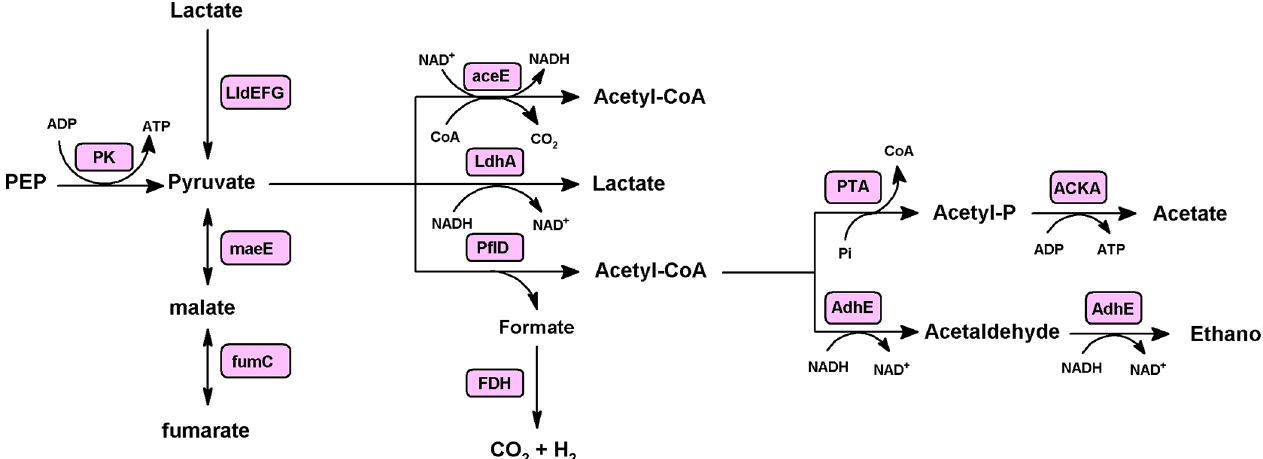
Fig 4. Scheme showing predicted pyruvate fermentation pathway in A . schaalii . The genesfound in A . schaalii suggest that pyruvate is either oxidativelydecarboxylated to acetyl-CoAvia pyruvate dehydrogenase (pdh) or it may be reducedto lactate by the action of lactate dehydrogenase or it may be convertedto acetyl-CoAand formate by pyruvate-formate lyase. Acetyl-CoA may be converted into ethanol, duringwhich 2 NADH are oxidizedvia a fused acetaldehyde/alcoholdehydrogenase encodedby adhE , ot it may be converted to acetate through an acetyl phosphate intermediate using phosphotransacetylase (pta) and acetate kinase (ack) with the concomitant productionof ATP. Abbreviations: LDH, L-lactate dehydrogenase; PTA, phosphotransacetylase; AK, acetate kinase.